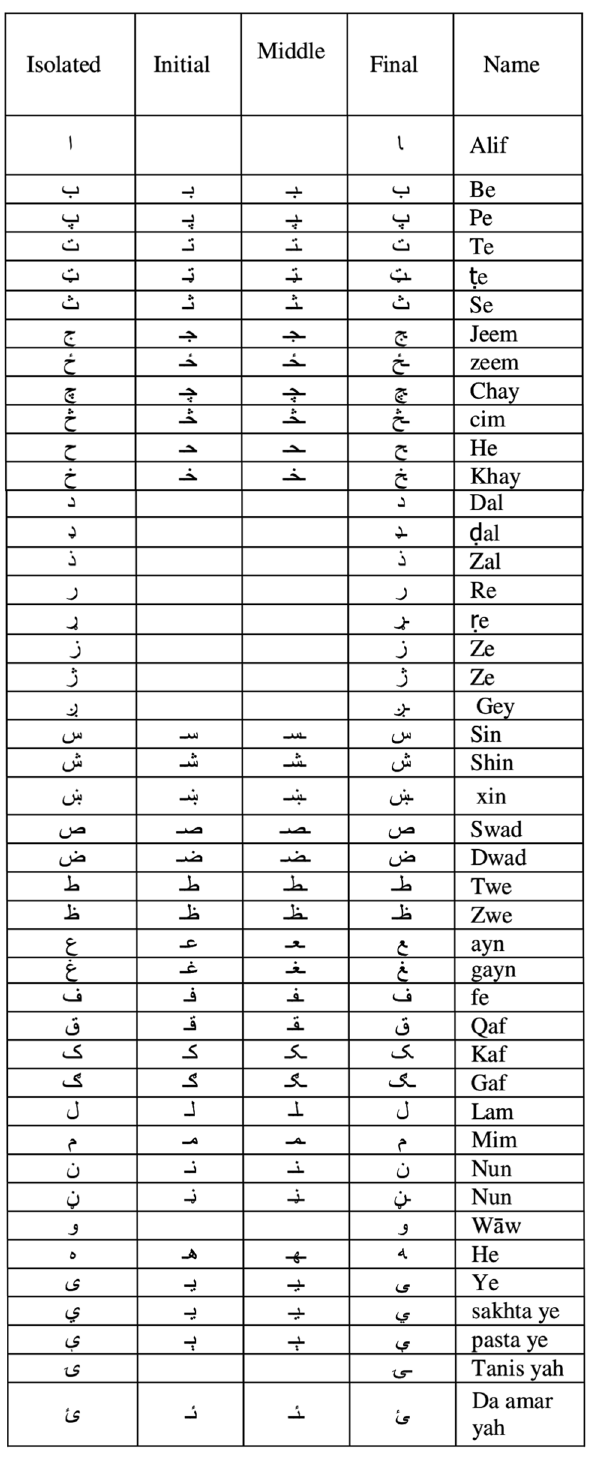
Fig 2. Shape variation of characters within Pashto character set [13].